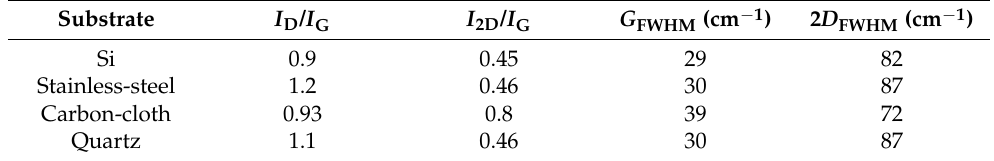
Table 2. The parameters extracted from Raman spectra for the VFLG grown on different